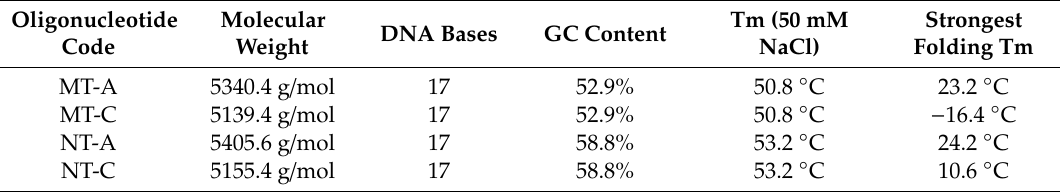
Table 2. Data on the oligonucleotides